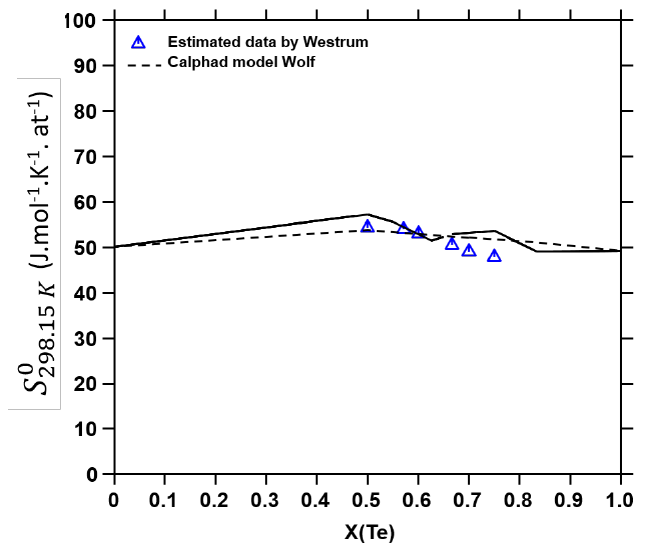
Figure 5. Calculated standard entropy at 298.15 K of UTe, U 3 Te 4 , U 2 Te 3 , UTe 2 , U 2 Te 5 , and UTe 3 . Comparison with the estimated data from Westrum [21] and the model of Wolf